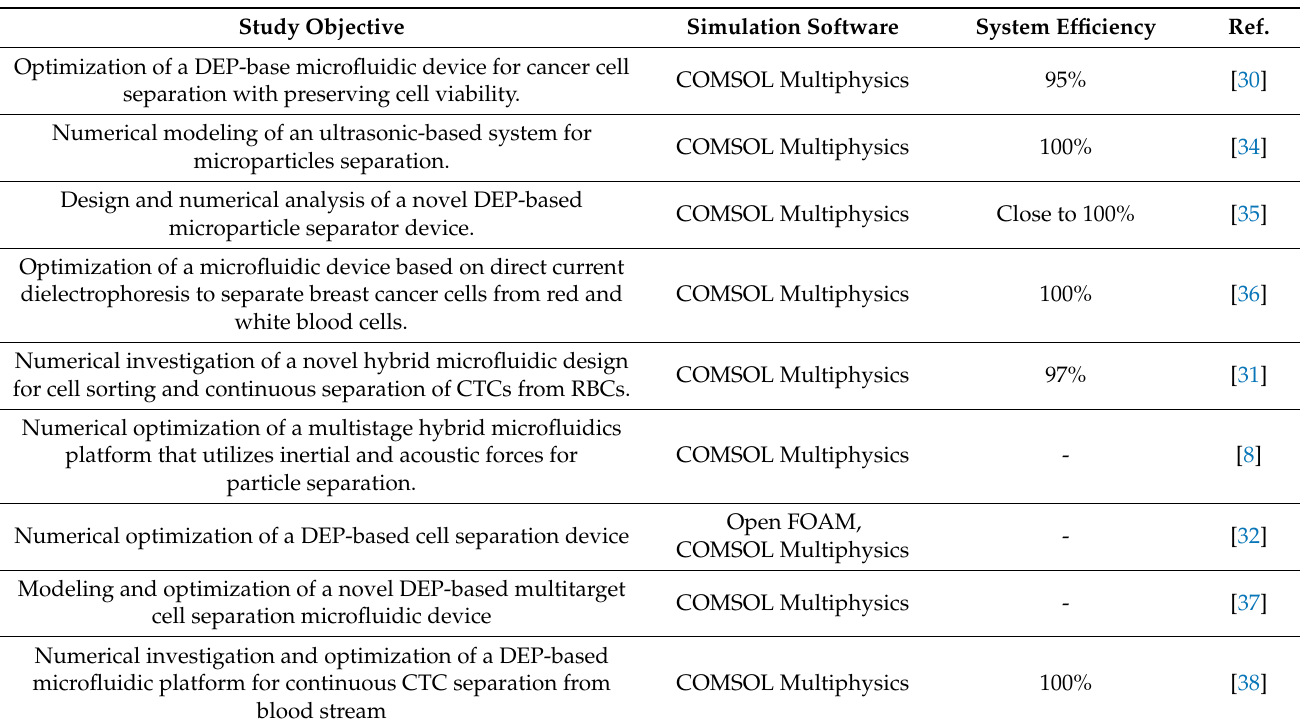
Table 1. A summary of recent numerical studies on microfluidic